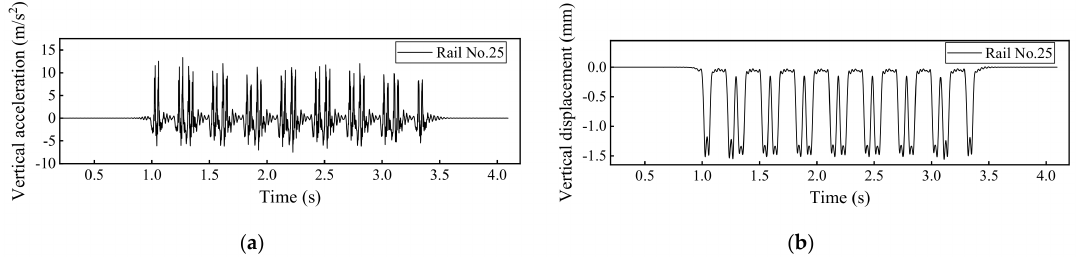
Figure 10. Model-calculated dynamic responses of the first passenger vehicle (the No. 2 railcar): ( a ) Vertical acceleration and ( b ) lateral acceleration.